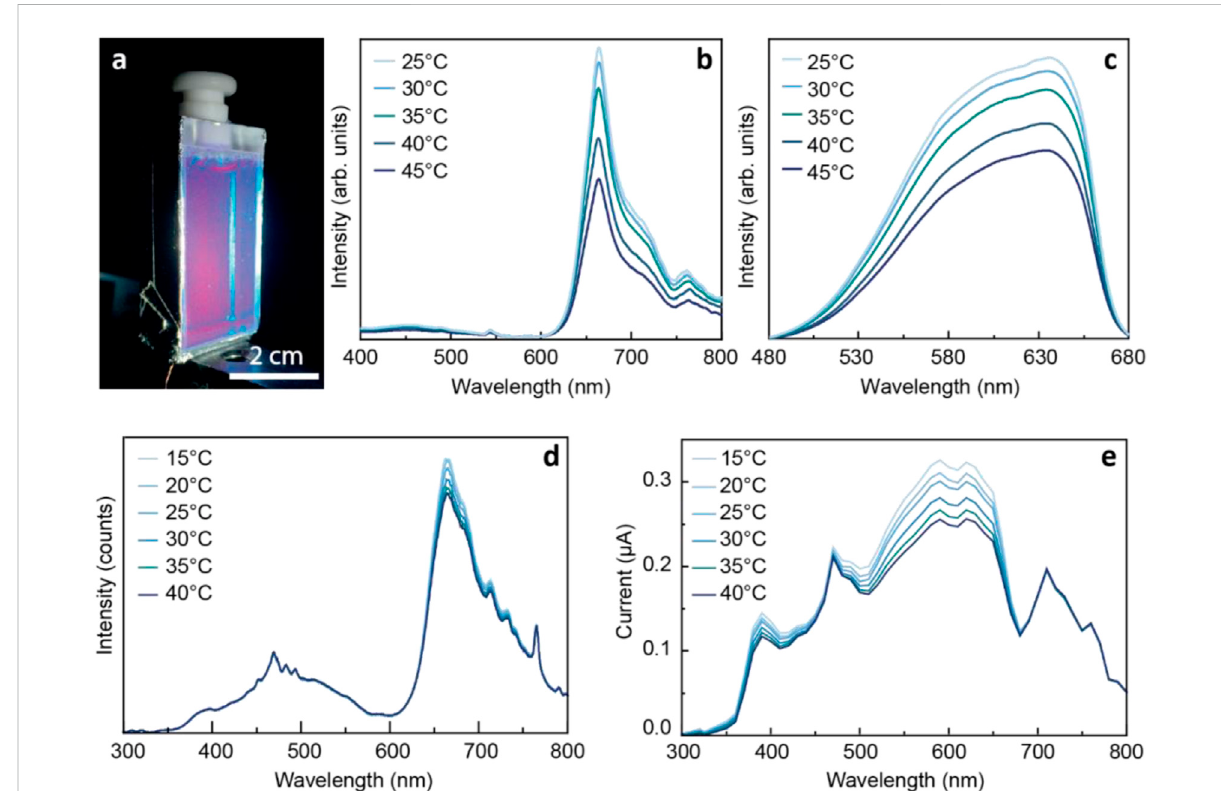
FIGURE 2 (A) Photograph of the LSC/sensor based on a glass container fi lled with PC-based aqueous solutions under AM1.5G illumination. The PV cell is located at the bottom edge. PC-based optical sensors temperature-dependent (B) emission and (C) excitation spectra excited at 380 nm and monitored at 715 nm, respectively, and (D) emission spectra and (E) generated short-circuit current under solar simulator irradiation. Reproduced from (Correia et al., 2022) under a CC BY 4.0 license.